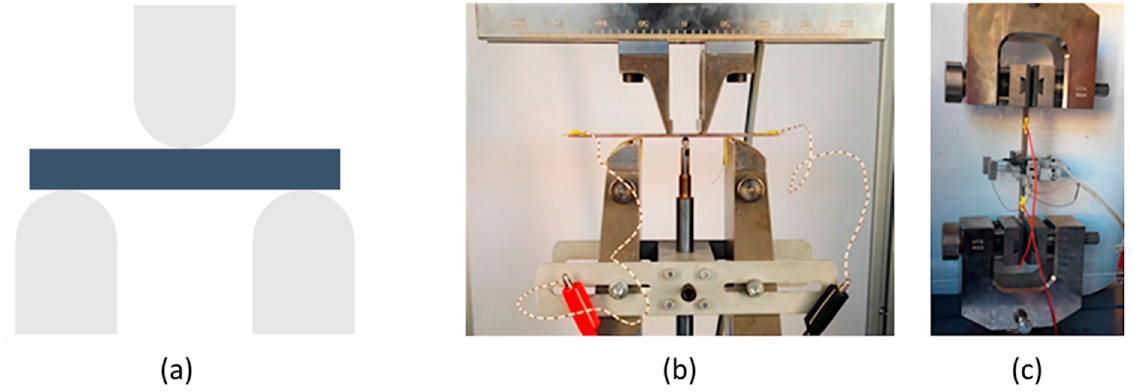
Figure 12. Mechanical tests mostly applied for structural batteries: Short span three ‐ point bending test ( a ) , four ‐ point bending test on plain plates ( b ) and tensile test on plain coupons ( c ) [7].